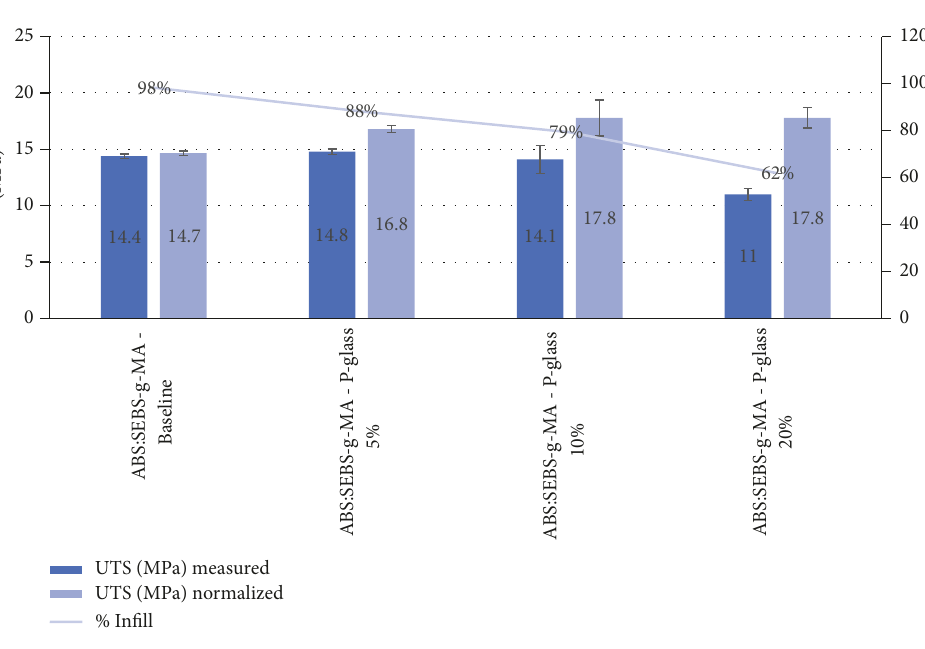
Figure 17: Normalization of UTS values for ABS:SEBS-g-MA system.